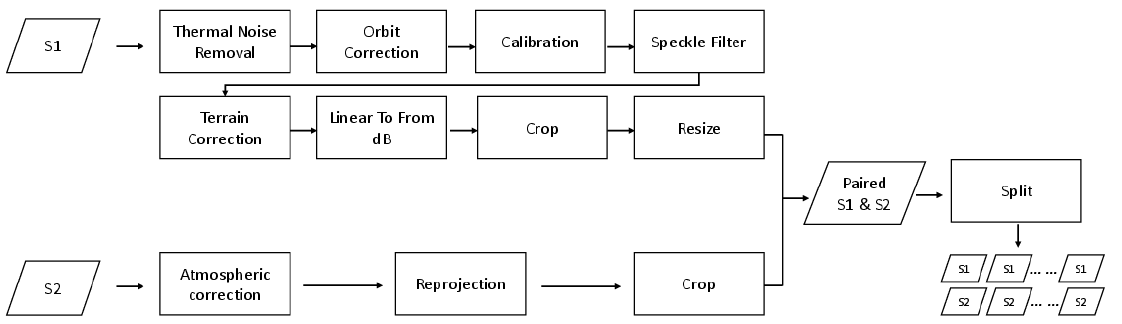
Figure 1. The flowchart of the data